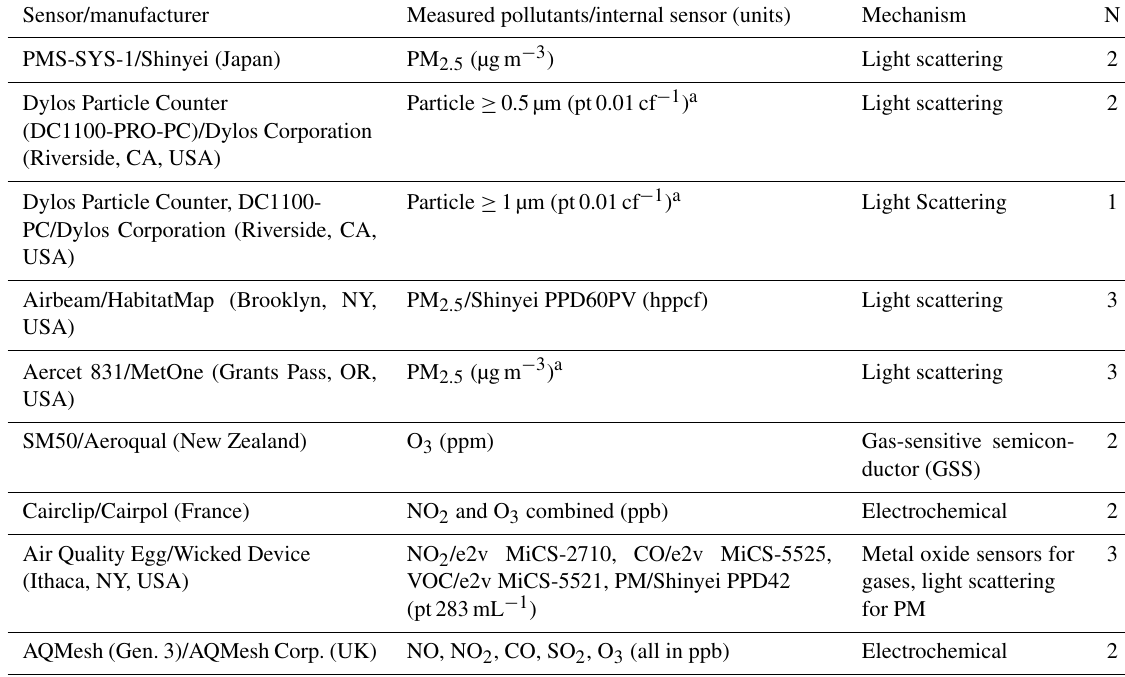
Table 1. Sensors selected for collocation ad hoc field testing